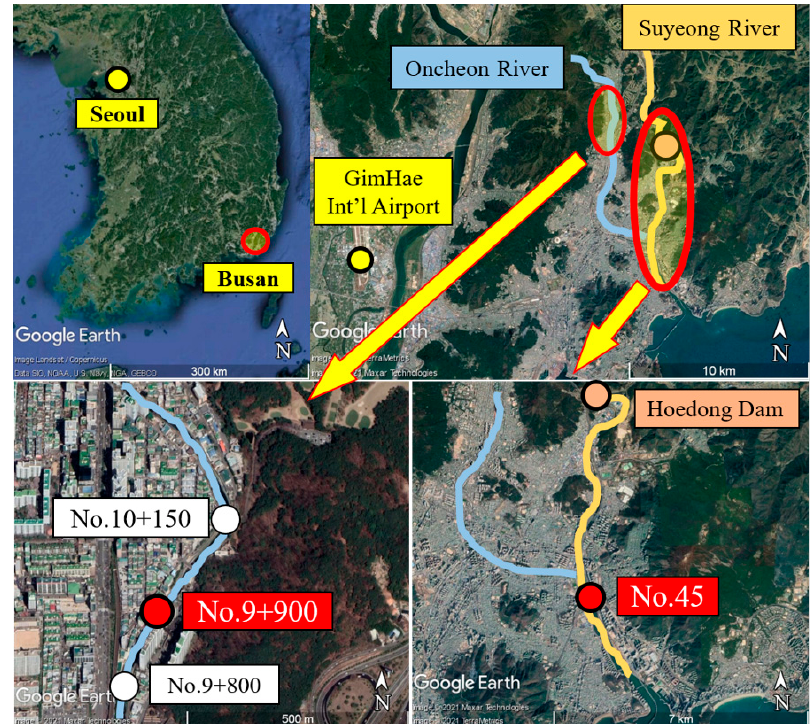
Figure 1. Study area. Point No. 10+150: 35 ◦ 15 (cid:48) 19.28” N, 129 ◦ 5 (cid:48) 40.11” E; Point No. 9+900: 35 ◦ 15 (cid:48)